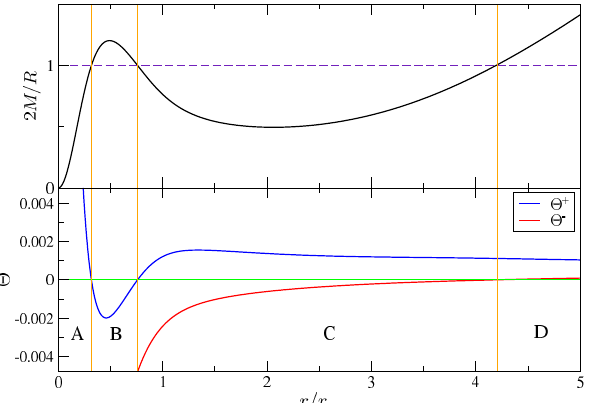
Figure 2. ( Top-panel ): Profile of 2 M / R once the trapped surface has been formed. The dashed line corresponds to 2 M / R = 1. ( Bottom-panel ): Profiles of the two expansions Θ ± at the same time t as the top panel. The vertical orange lines correspond to points where Θ ± = 0. The initial fluctuation considered corresponds to a Gaussian